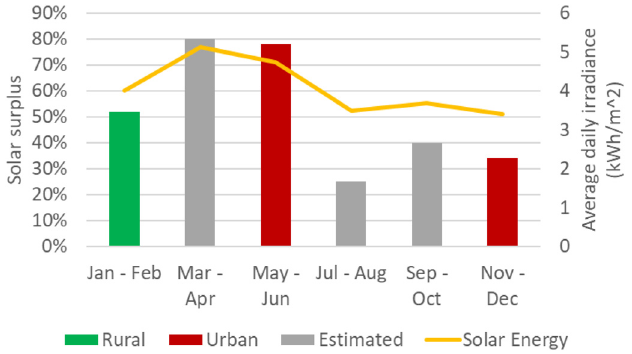
Fig. 7. Variation of Annual trends in Solar surplus SHS in Odisha, India.